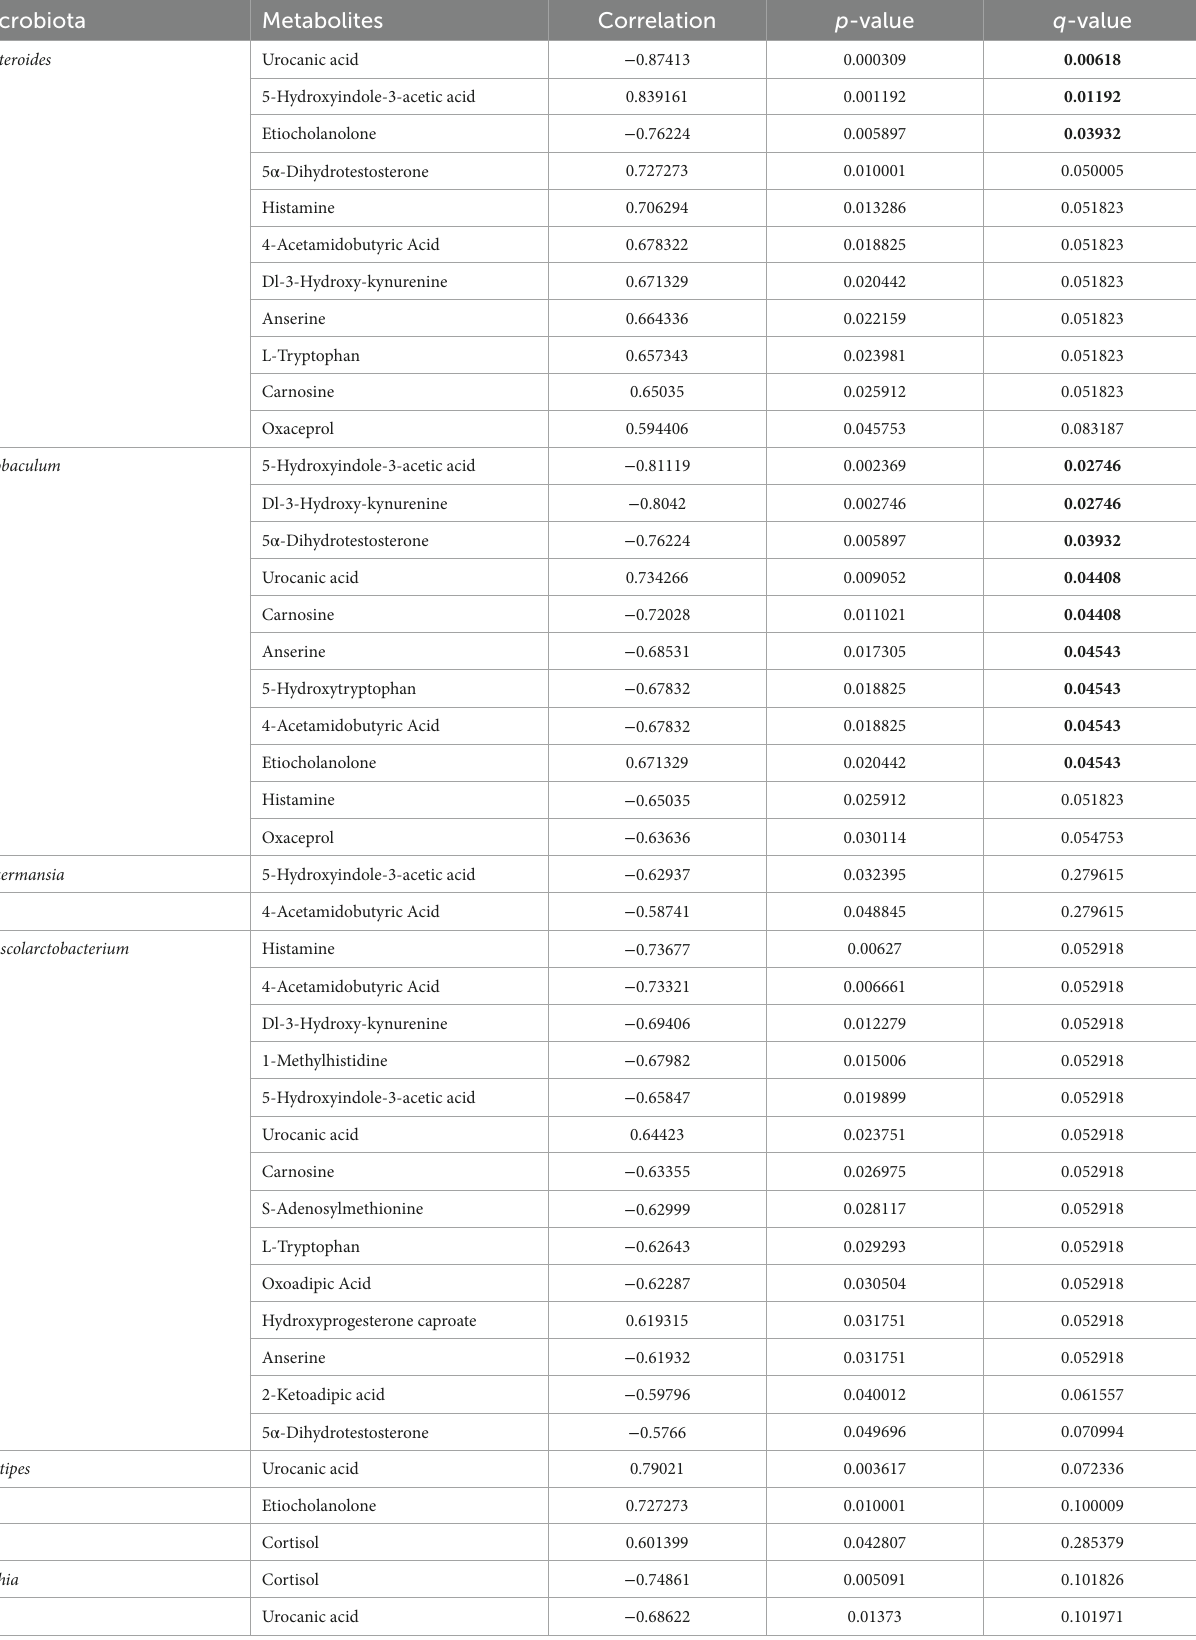
TABLE 1 The Spearman’s correlation significantly changed between intestinal differential metabolites and bacteria